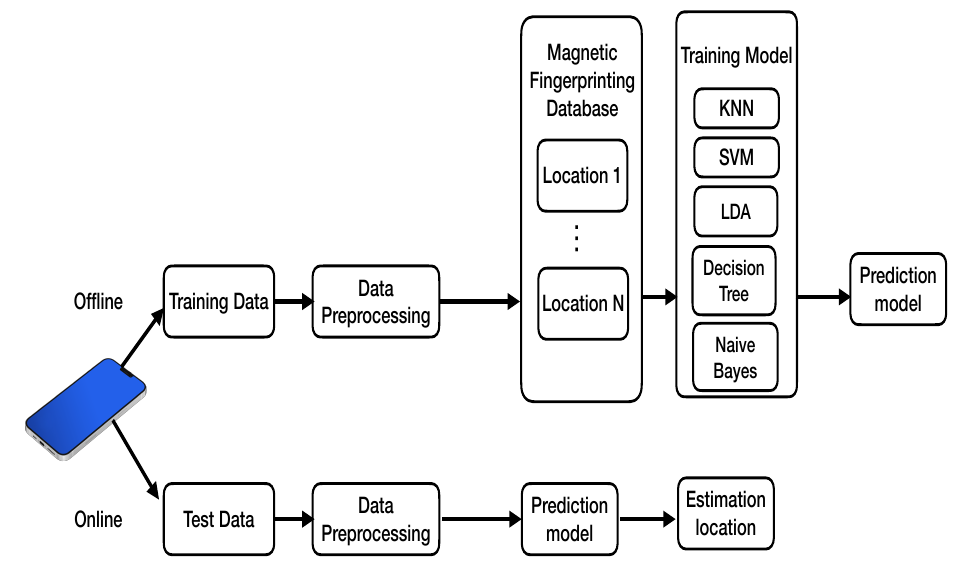
Figure 9. Machine learning scheme for indoor